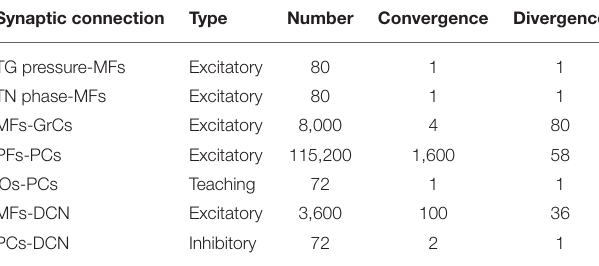
FIGURE 2 | SNN implementation of the cerebellum. Whisking sensory signals are conveyed to the cerebellar MFs from TG pressure and TN phase neurons, while the reward signal during correct GO trials reaches the IO neurons; the cerebellum controls the output motor response (head movement) according to DCN activity (i.e., generation of a response, head raise, when the firing rate exceeds a set threshold). Arrows and circles represent excitatory and inhibitory connections, respectively.